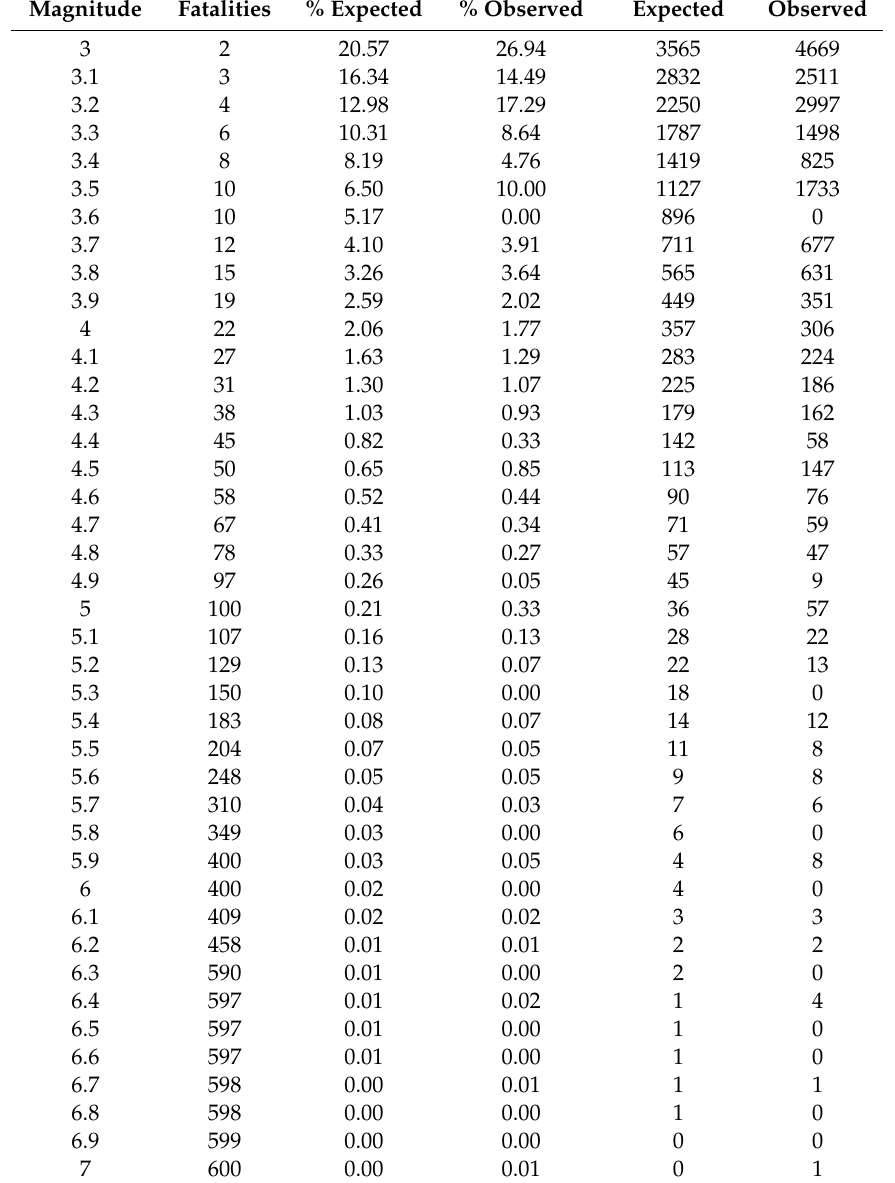
Table A1. The magnitude distribution of the social conflict data. For each magnitude, there is the corresponding number of fatalities, the expected percentage of events, the observed percentage of events, the expected number of events and the observed number of